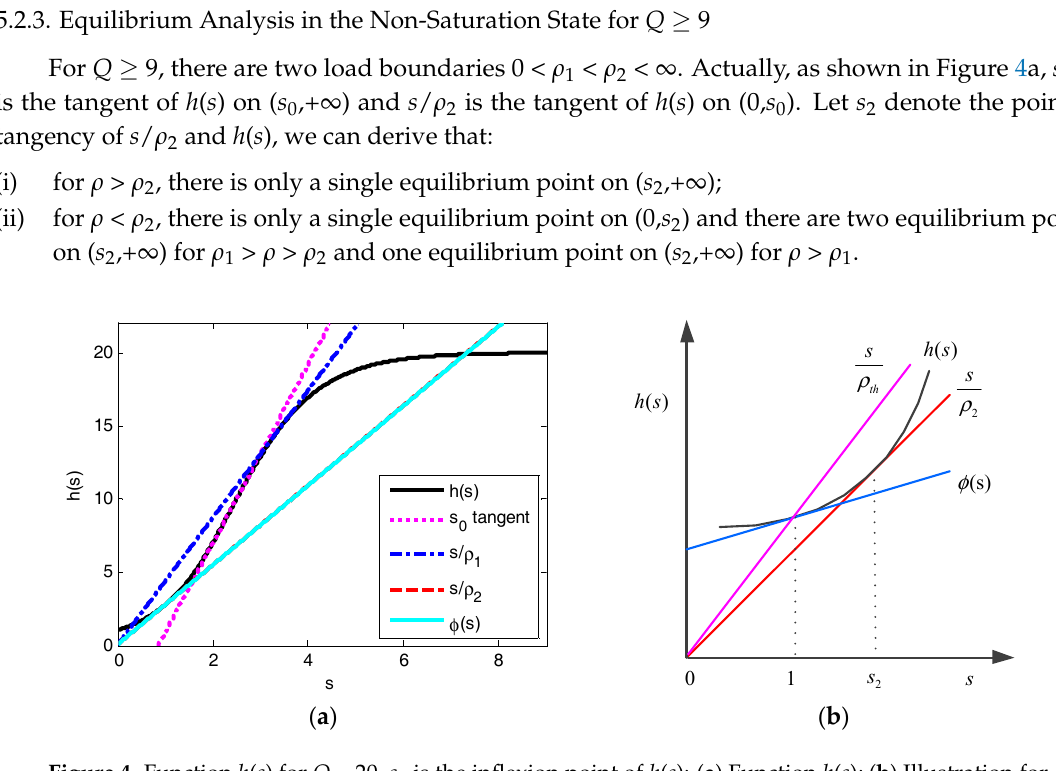
Figure 4. Function h ( s ) for Q = 20, s 0 is the inflexion point of h ( s ): ( a ) Function h ( s ); ( b ) Illustration for proof of s 2 ≥ 1.